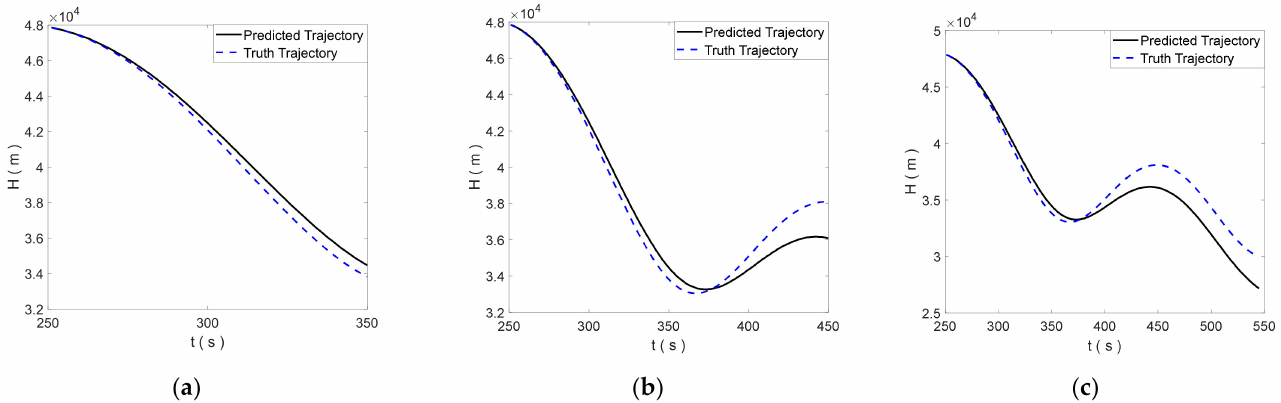
Figure 17. Longitudinal prediction effect of case 2: ( a ) is the longitudinal prediction effect within 100 s; ( b ) is the longitudinal prediction effect within 200 s; and ( c ) is the longitudinal prediction effect within 300